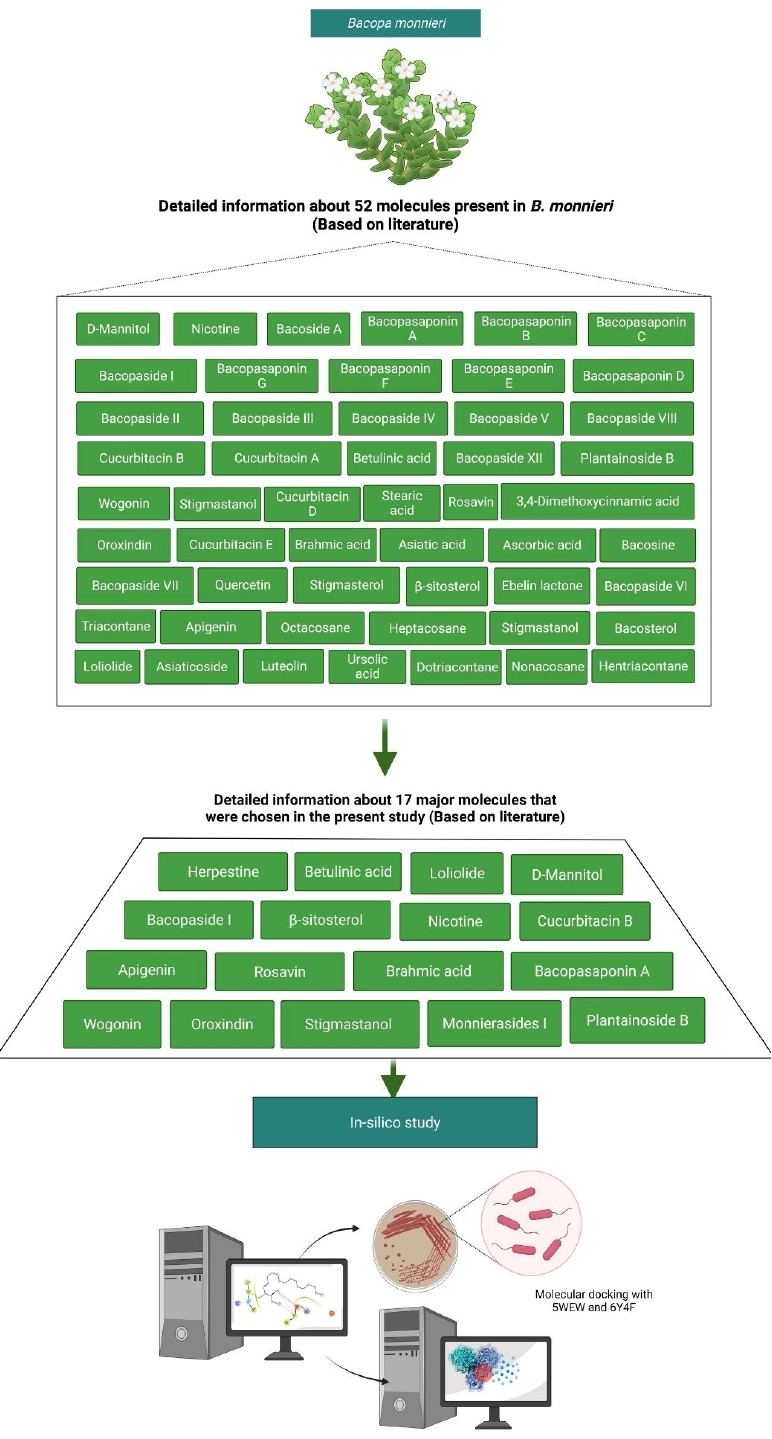
Figure 9. Overall process of the selected molecules from B. monnieri for in silico study .